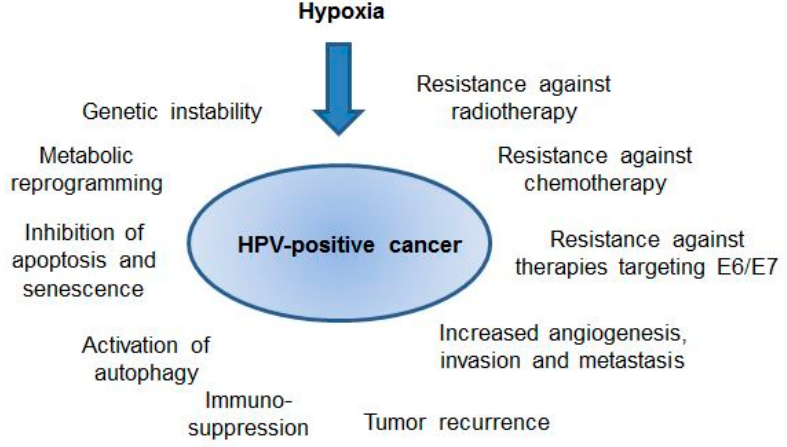
Figure 2. Potential effects of hypoxia on the biology and clinical behavior of human papillomavirus (HPV)-positive cancers. For further details please refer to the text.